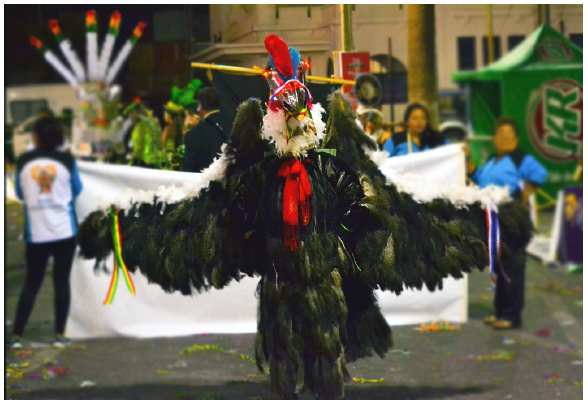
Fig. 4 . Dancer representing an Andean Condor at the Carnival with the Force of Sun, Arica, 2017 (Photo by Andrés Jacques-